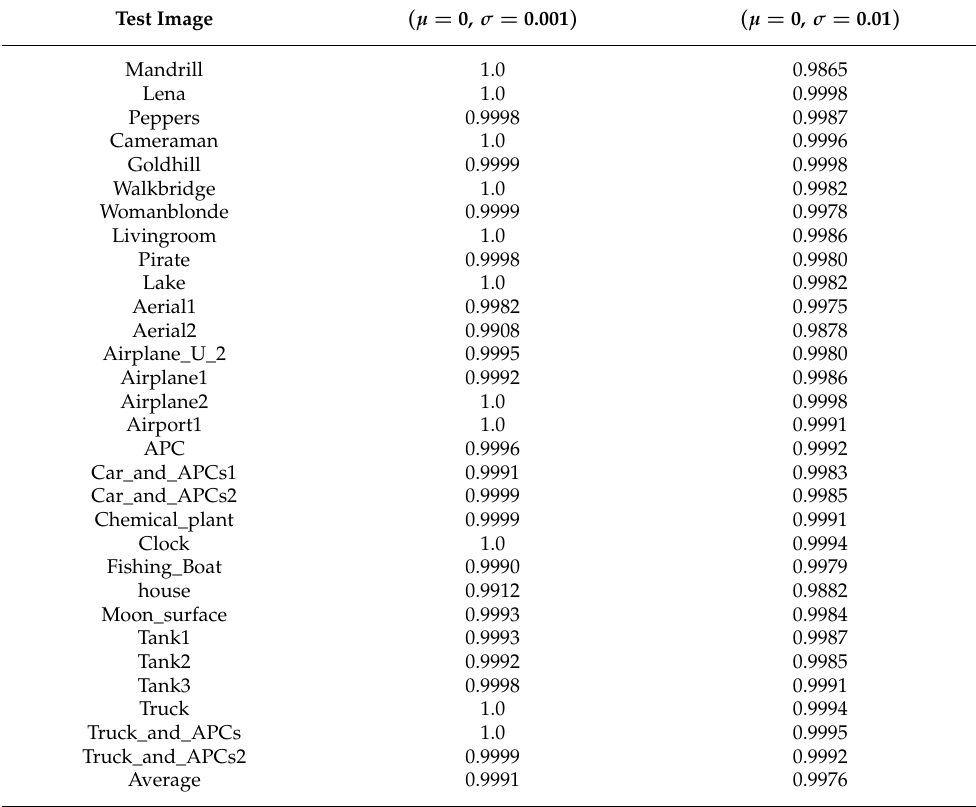
Table 2. Watermark robustness measured in terms of NC against Gaussian noise for several test images. Test